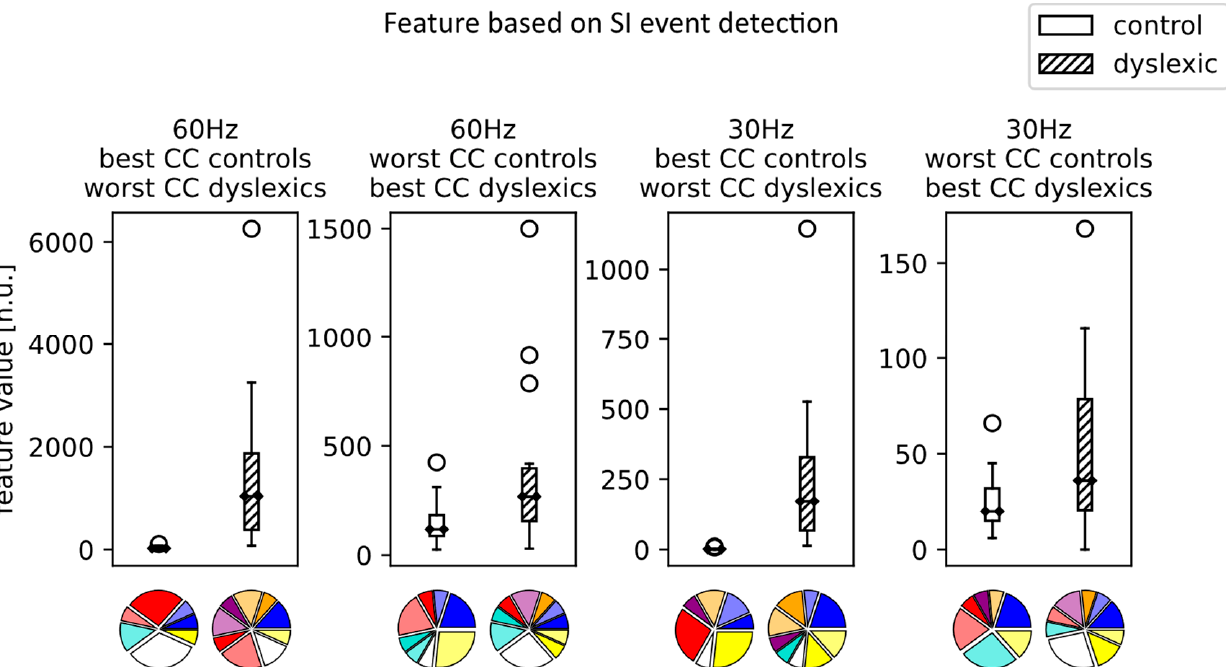
Figure 3. The boxplots showing SI event feature values for the maximally separated classes (control subjects evaluated on their best CC and the dyslexic subject evaluated on their worst CC) and the classes brought together (dyslexic subjects evaluated on their best CC and the control subject evaluated on their worst CC). Below each boxplot is a pie chart displaying the distribution of CCs that were used for the subjects’ feature values (best- or worst-performing CCs).